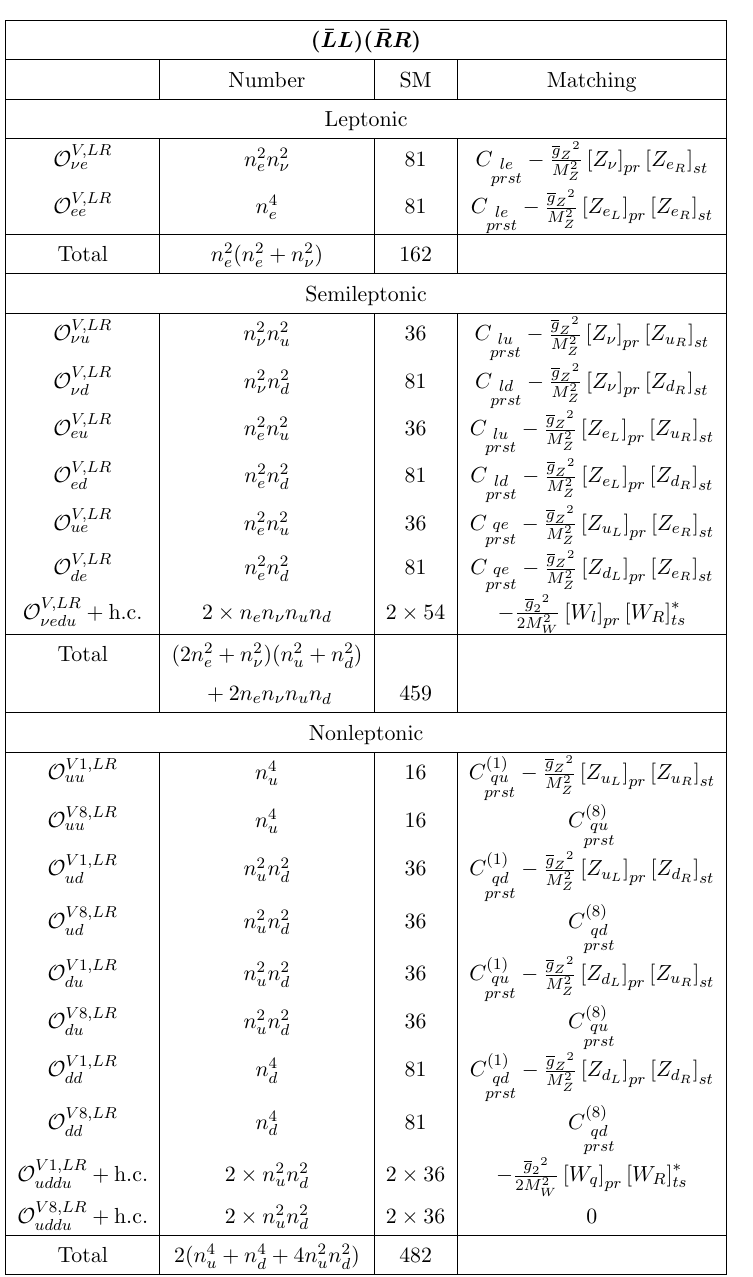
Table 15 . Dimension-six four-fermion operators: left-handed times right-handed currents in LEFT. The (¯ LL )( ¯ RR ) operators are divided into leptonic, semileptonic, and nonleptonic opera- V,LR V 1 ,LR V 8 ,LR tors. Semileptonic operators and nonleptonic operators and all come with νedu uddu uddu O O O additional Hermitian conjugate operators. All other operators are Hermitian. The second column is the number of operators for an arbitrary number of neutrino flavors n ν , charged lepton flavors n e , u -type quark flavors n u , and d -type quark flavors n d , and the third column is the number in the SM LEFT with n ν = 3, n e = 3, n u = 2, and n d = 3. The last column is the tree-level matching coefficient in SMEFT.